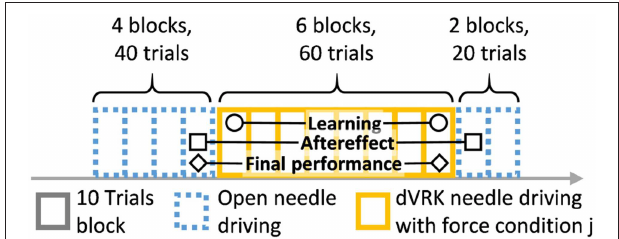
FIGURE 5 | Experimental protocol. Participants performed 120 trials of needle driving that were divided into 12 blocks. In our statistical analysis, we focused on 3 contrasts: learning, aftereffect and final performance. Learning: the effect of practice in teleoperation—the difference in performance between early and late teleoperation. Aftereffect: the effect of teleoperation on open needle driving—difference in performance between just before and just after teleoperation. Final performance: the performance at the end of teleoperation compared to the participant’s baseline—the difference between the late teleoperation performance and the performance just before